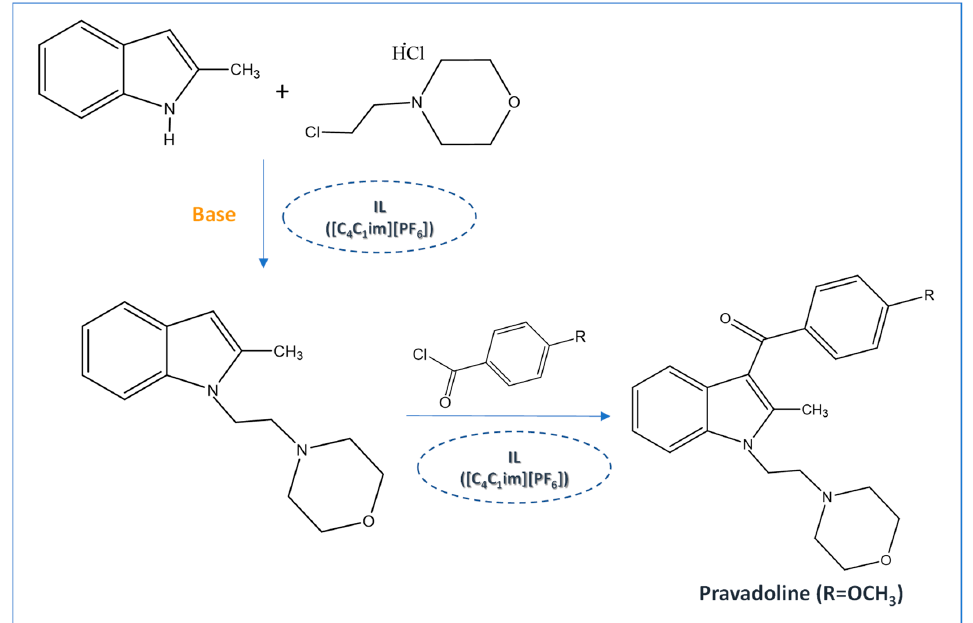
Figure 4. Pravadoline synthesis in an IL media proposed in [51].